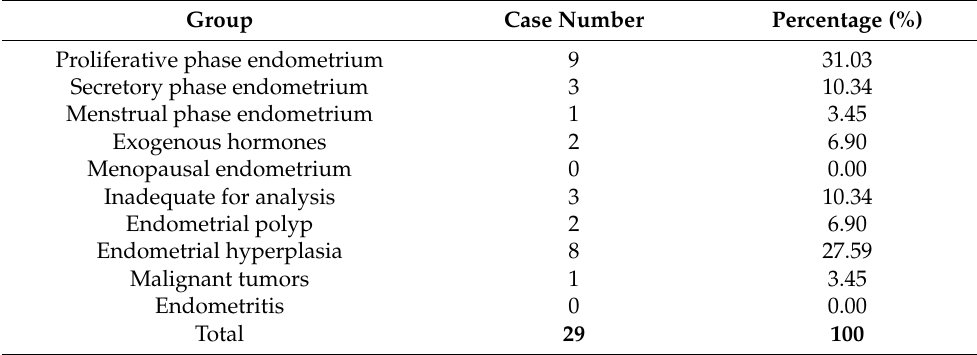
Table 11. Histopathological findings of clinically suitable samples extracted by hysteroscopy with endometrial biopsy procedure.